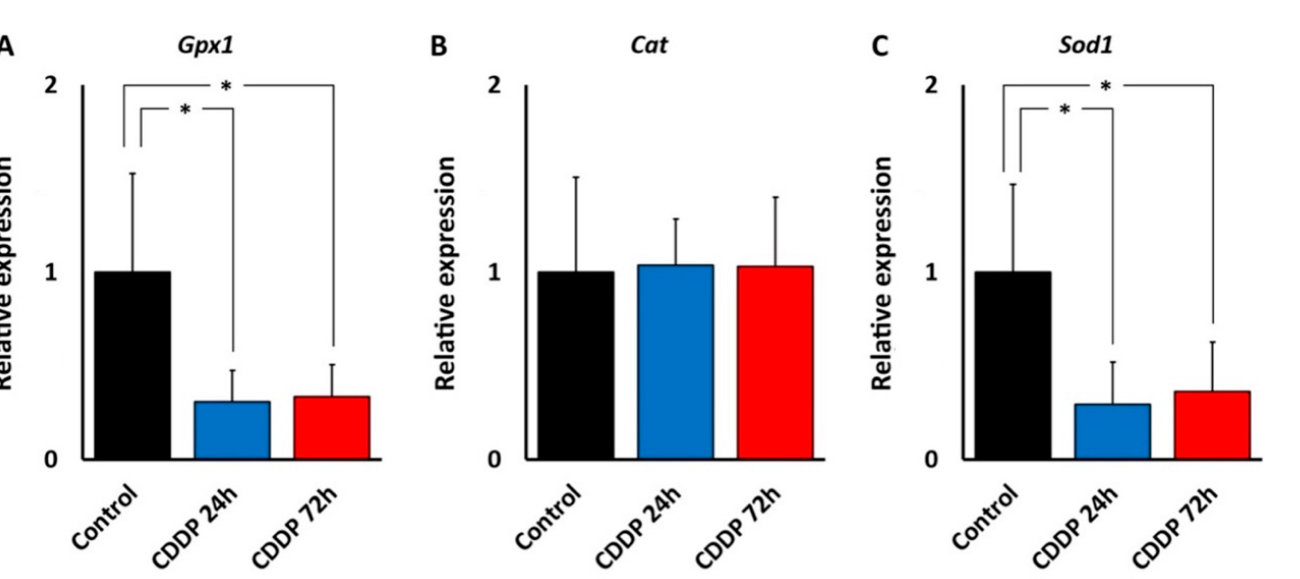
Figure 9. Changes in the expression of antioxidant enzyme genes in the cochlea with cisplatin treatment (CDDP). A: Relative expression levels of the Gpx1 ( A ), Cat ( B ) and Sod1 ( C ) genes under conditions of cisplatin ototoxicity at 24 h and 72 h after injection. See text for details. Asterisks indicate statistical significance values, as specified in Section 2.6, Materials and Methods.